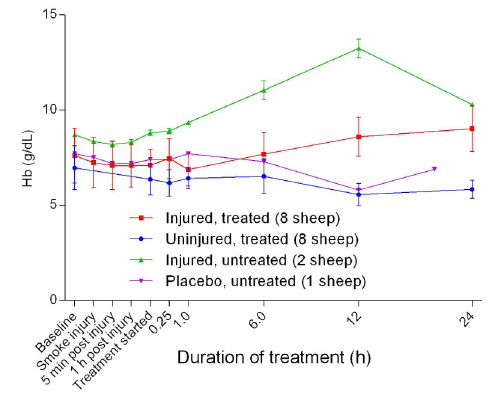
Figure 8. Haemoglobin concentration [Hb] (Mean ± SD) in smoke and non-smoke injured sheep that received extracorporeal life support as compared to that in treated controls. ) 2